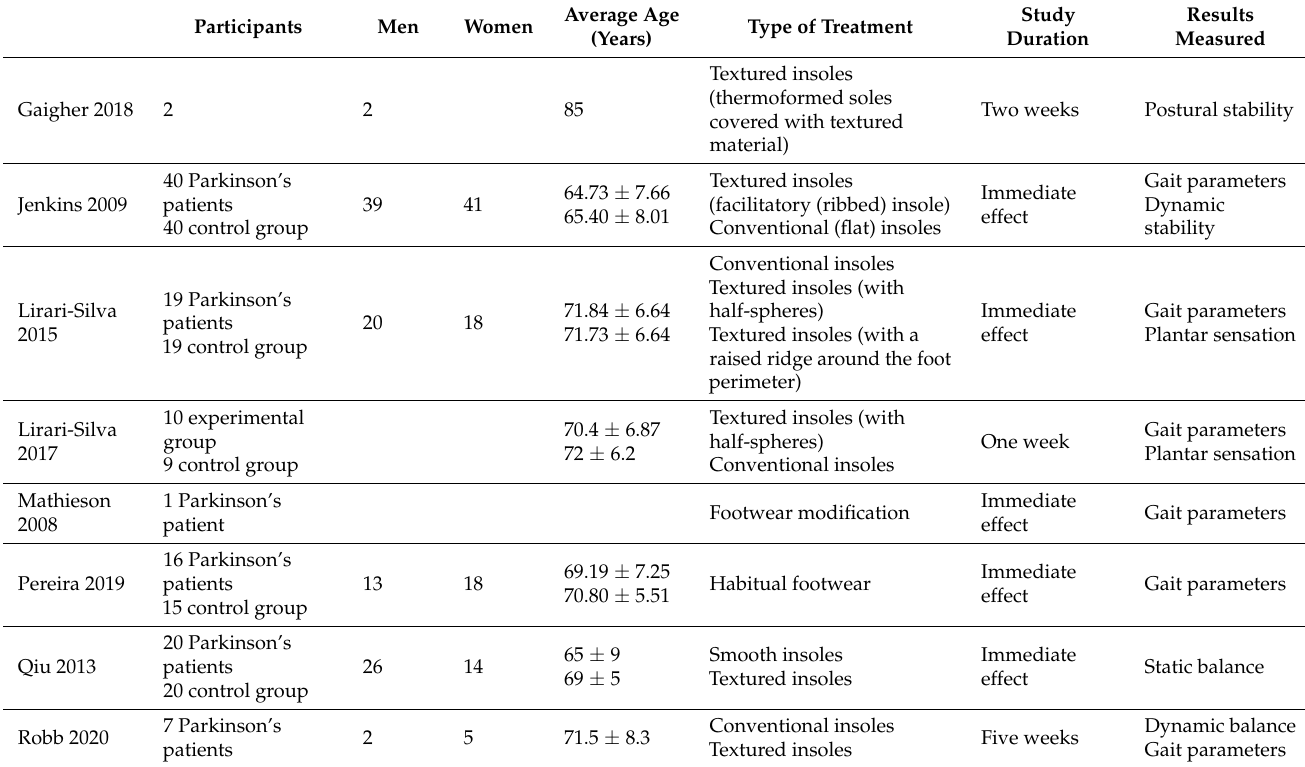
The risk of bias in the studies included is shown in Figure